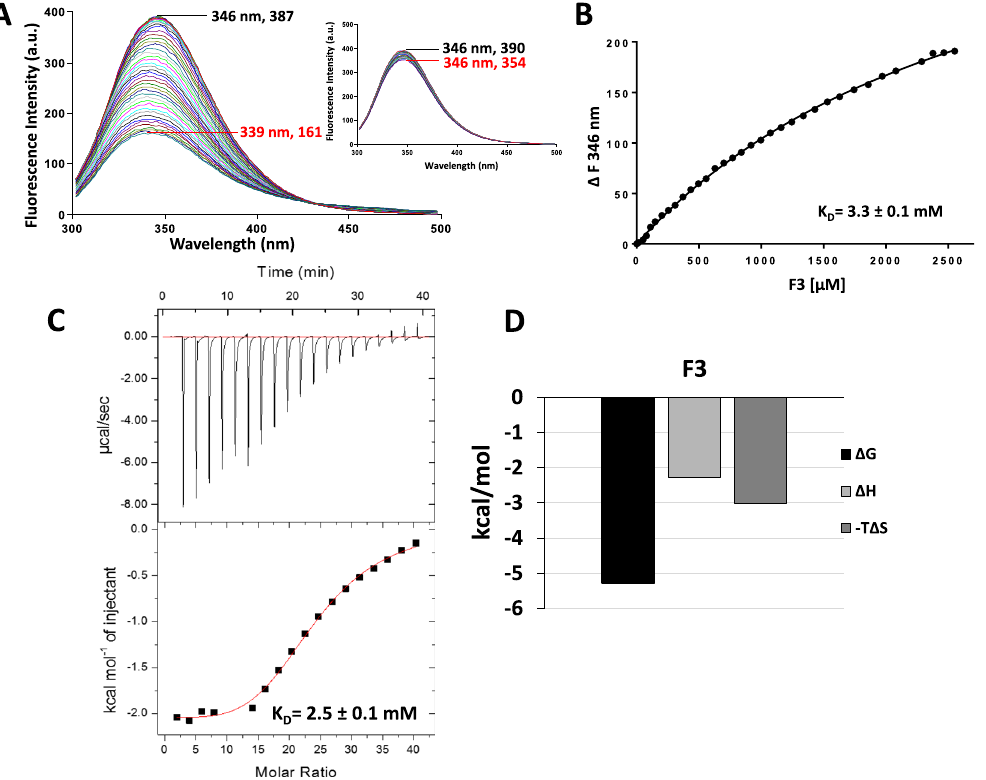
Figure 8. Analysis of galectin-3 interaction with ligand F3 by TFS and ITC. Galectin-3 (10 µ M) florescence intensity with increased concentrations of F3 were recorded by fluorescence spectroscopy ( A ). Numbers indicate the maximum fluorescence wavelength and corresponding fluorescence intensity for the first (no F3/ buffer titration, black) and last (red) titration traces. Insert in the figure shows buffer control titrations. Ligand concentrations vs changes in fluorescence intensity were plotted and analysed using nonlinear curve fitting with One site- Specific binding model and the galectin-3 binding affinity to F3 was determined ( B ). Heat changes for titration of galectin-3 (100 µ M) with 20 mM F3 measured by ITC are shown in ( C ) (upper panel) with logistic fit of the data (bottom panel). Panel (D) shows thermodynamic profiles with enthalpy ( ∆ H), entropy ( ∆ S) and Gibbs free energy ( ∆ G) changes associated with galectin-3 binding to